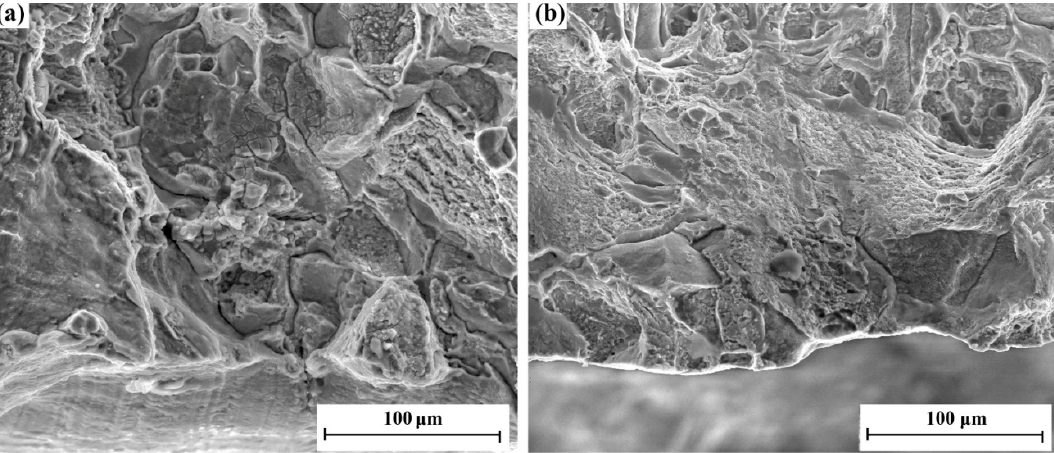
Figure 2. The fracture morphology of stress corrosion: ( a ) 35 °C 3.5 % NaCl solution and ( b ) 35 °C dry air.